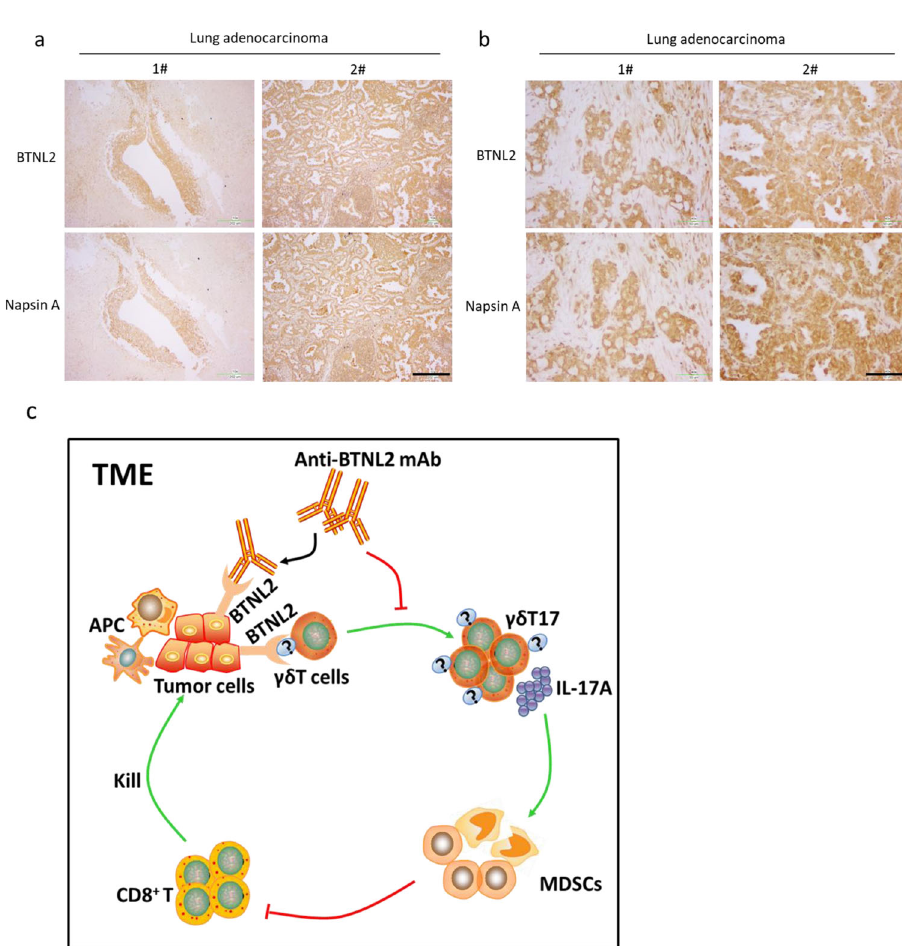
Fig. 7 BTNL2 was strongly expressed in some of PD-1 inhibitor treatment-resistant lung cancer samples. a , b Immunohistochemistry staining of BTNL2 and Napsin A expression in lung adenocarcinoma samples was shown (serial section of slices was stained with anti-BTNL2 and anti- Napsin A). Scale bar = 202 μ m for a , Scale bar = 50 μ m for b . “ P ” represents para-cancerous tissue; “ C ” represents cancer tissue. c Sketch Map of BTNL2 blockage in the TME was shown, that tumour cell-expressed BTNL2 promotes γδ T17 cells differentiation, which recruits MDSCs into TME to inhibit the cytotoxic function of CD8 + T cells. Blockage of BTNL2 by mAb abolishes the γδ T17 cells differentiation and subsequent recruitment of MDSCs, which re-activates CD8 + T cells for the tumour-cytotoxic function. Data in a , b are representative of three independent